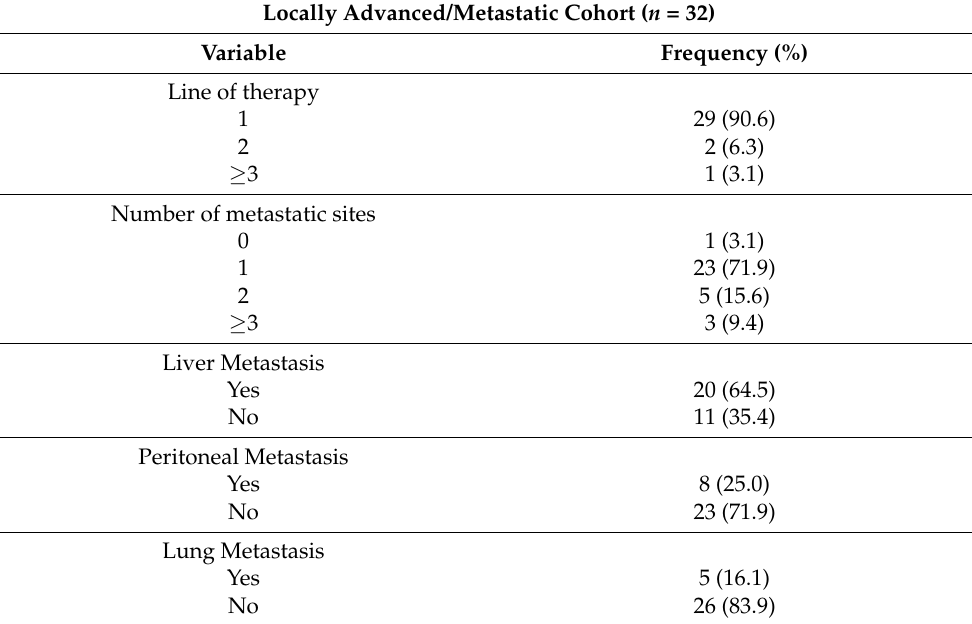
Table 2. Characteristics of patients with locally advanced or metastatic PC ( n =